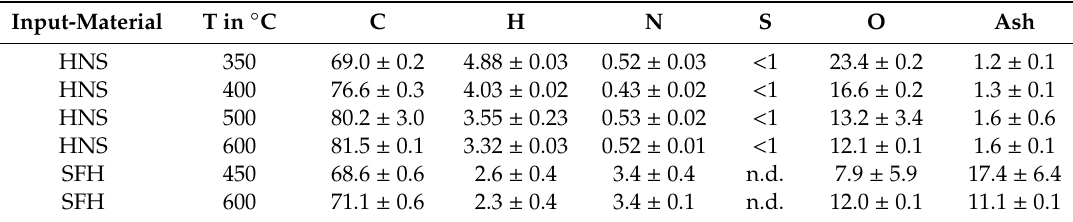
Table 1. Ultimate analyses of the biochar samples in wt% (dry-based); O content was calculated by di ff erence.